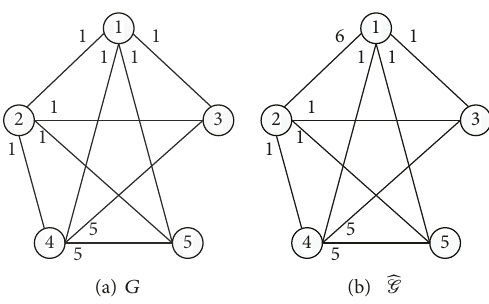
Figure 1: (a) Original system; (b) superposed